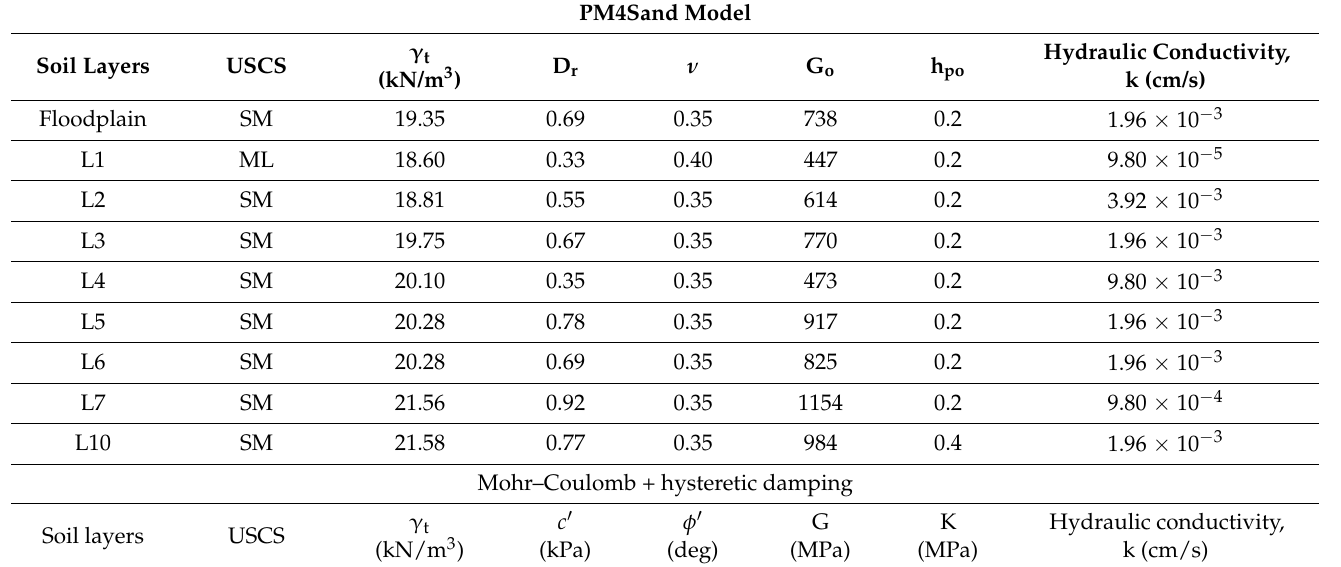
Table 7. The soil parameters for dynamic effective stress method (DESM).